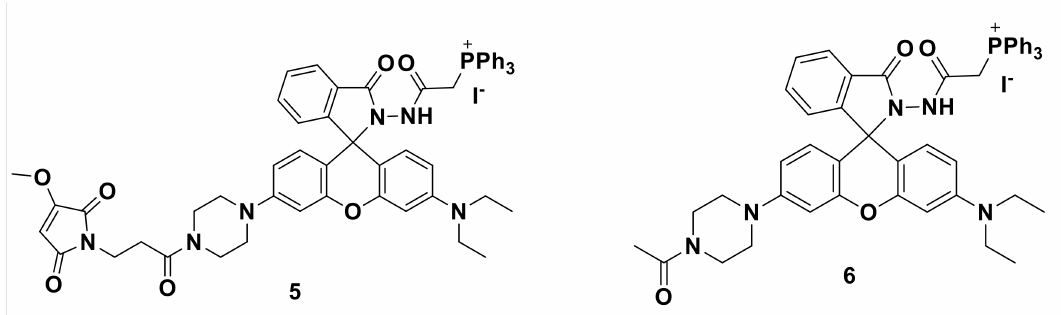
Figure 6. The structures of probe 5 and probe 6.